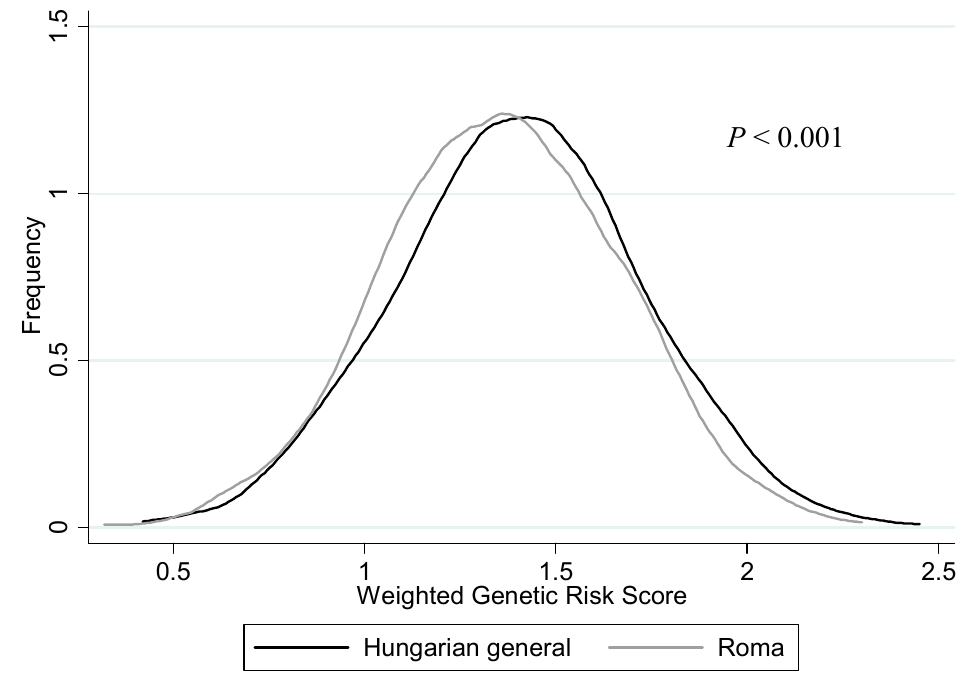
Figure 3. Distribution curves of weighted genetic risk scores by study population.